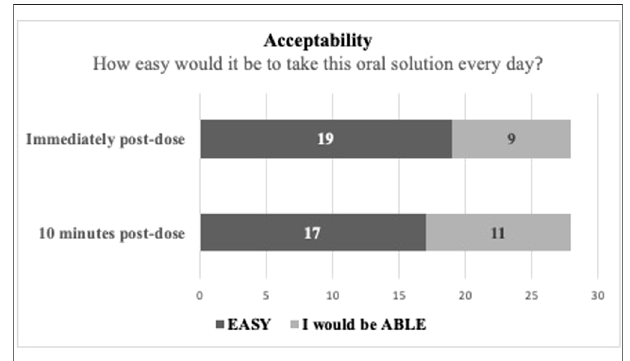
FIGURE 2 | Test solution acceptability evaluation in taste- and smell- sensitive subjects (N =